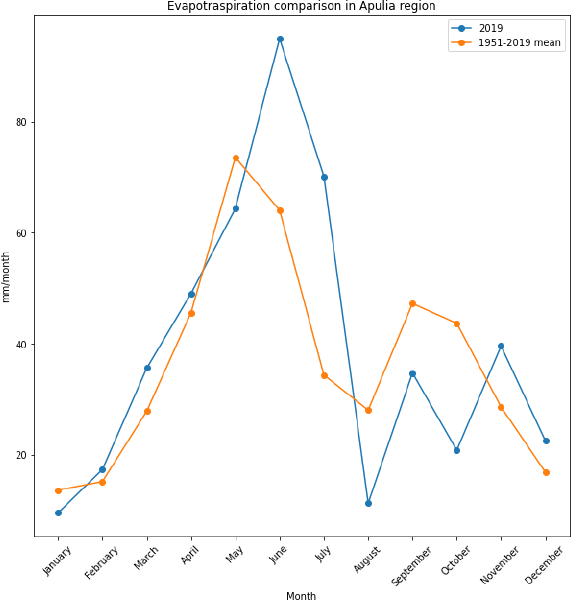
Figure 13. Comparison BIGBANG evapotranspiration of 2019 with the mean value from 1951 to 2019 for the Apulia